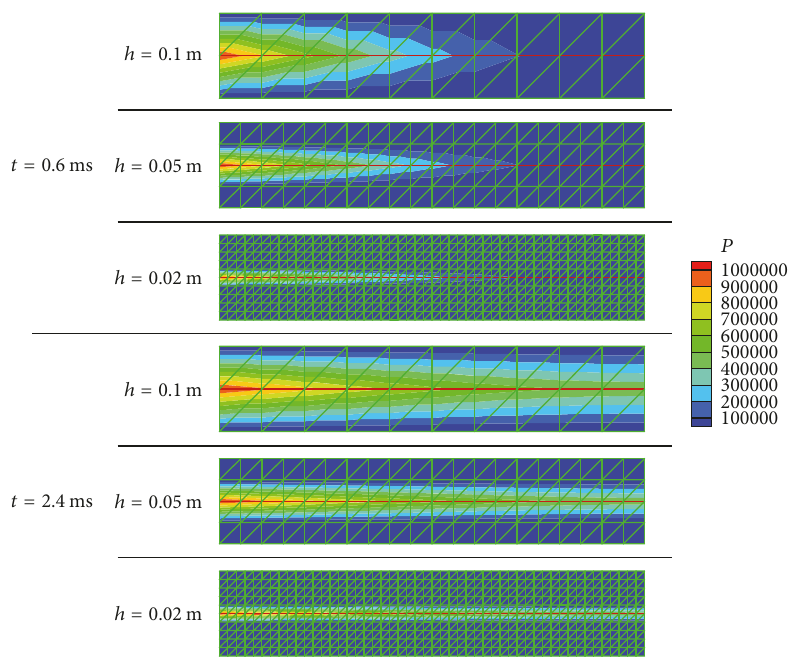
Figure 12: Hydraulic pressure distribution at different time with three sets of mesh size (Pa).